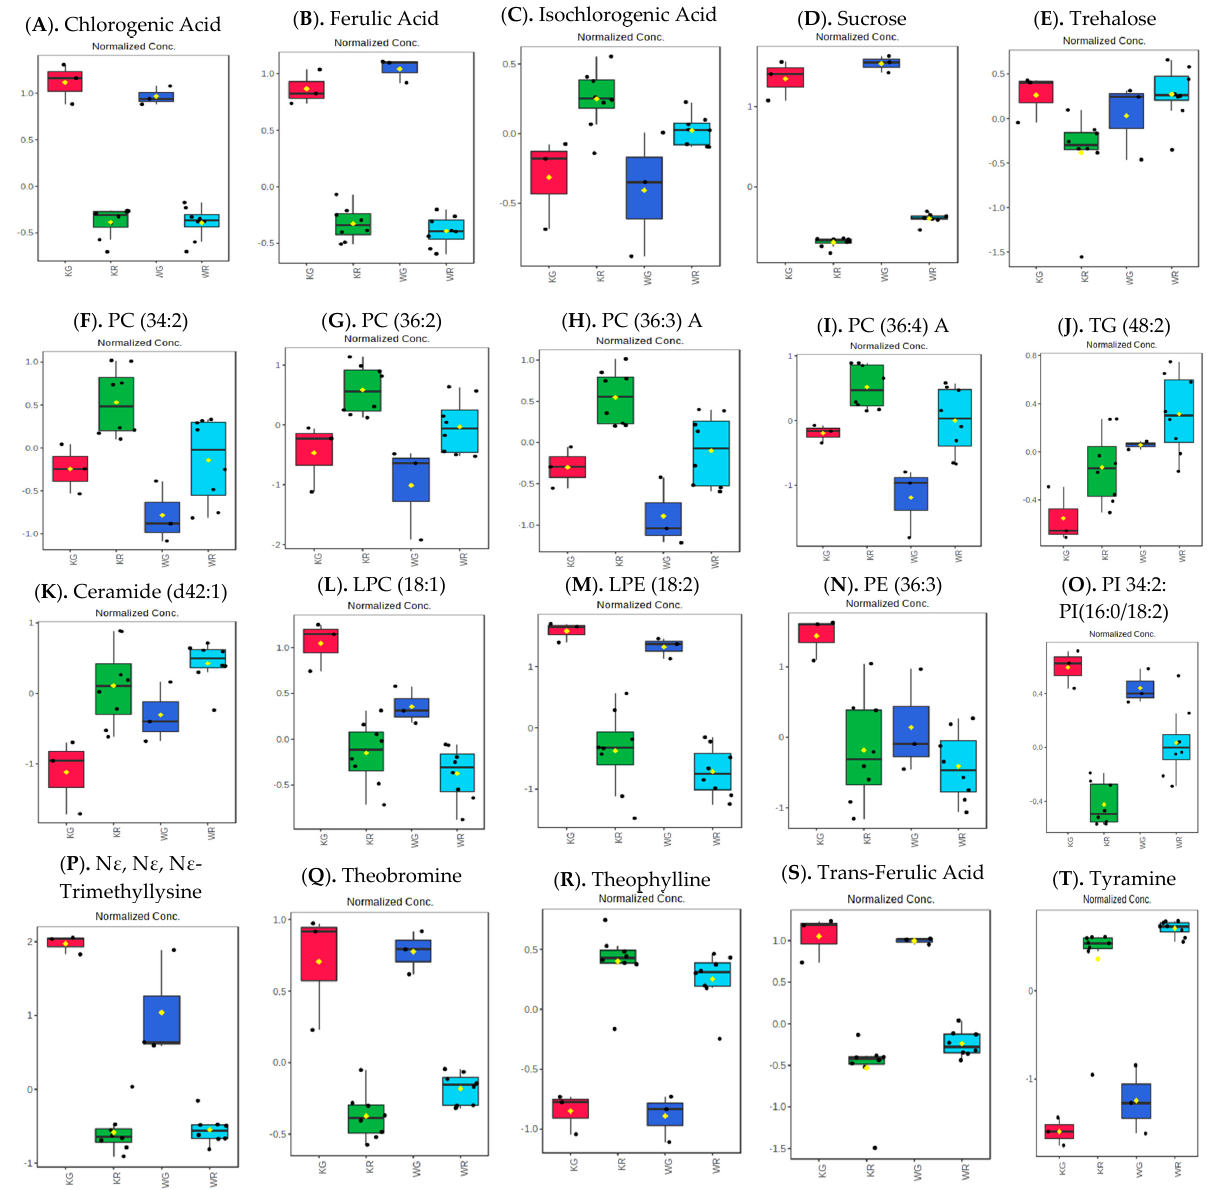
Figure 4. Relative changes of selected known metabolites ( A – E ), positive ESI lipids ( F – J ), negative ESI lipids ( K – O ), and amines ( P – T ) in green ( n = 3) vs. roasted ( n = 8) coffees ( p < 0.05). KG = Kaua’i green, KR = Kaua’i roasted, WG = Waialua green, and WR = Waialua roasted.